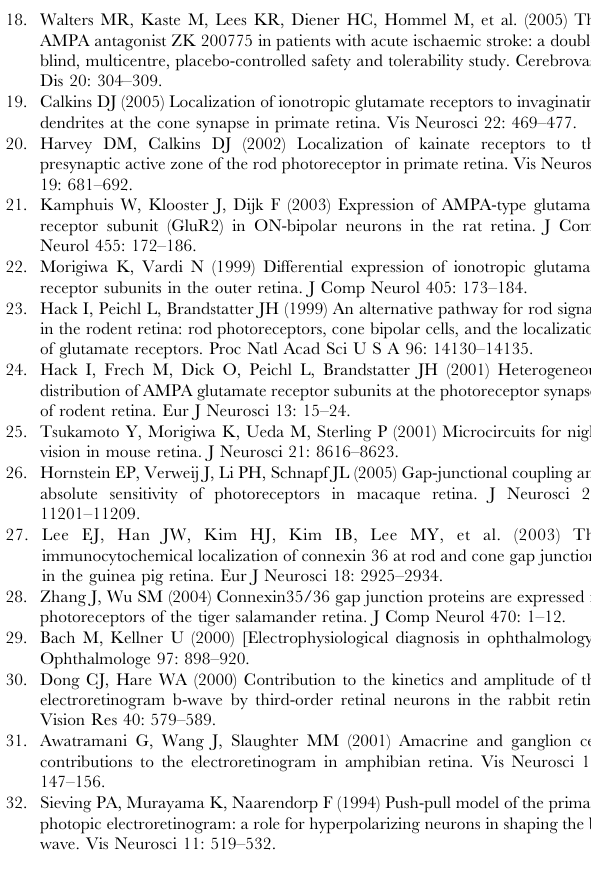
Figure S1 Glutamate receptor subtypes. Table S1 Ionotropic glutamate receptor expression in retinal neurons and retinal layers. Immunocytochemistry, in situ hybridization and polymerase chain reaction. Based on Webvi- sion, completed by the authors (http://webvision.med.utah.edu,